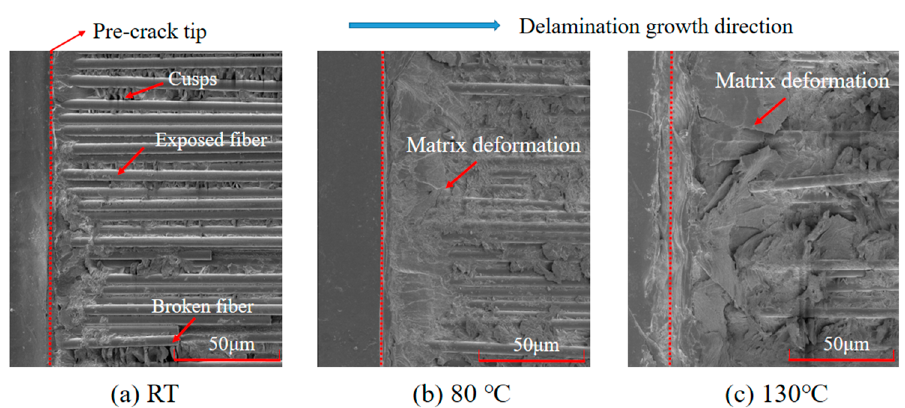
Figure 7. SEM images of fracture surfaces from the specimens tested at different temperatures.